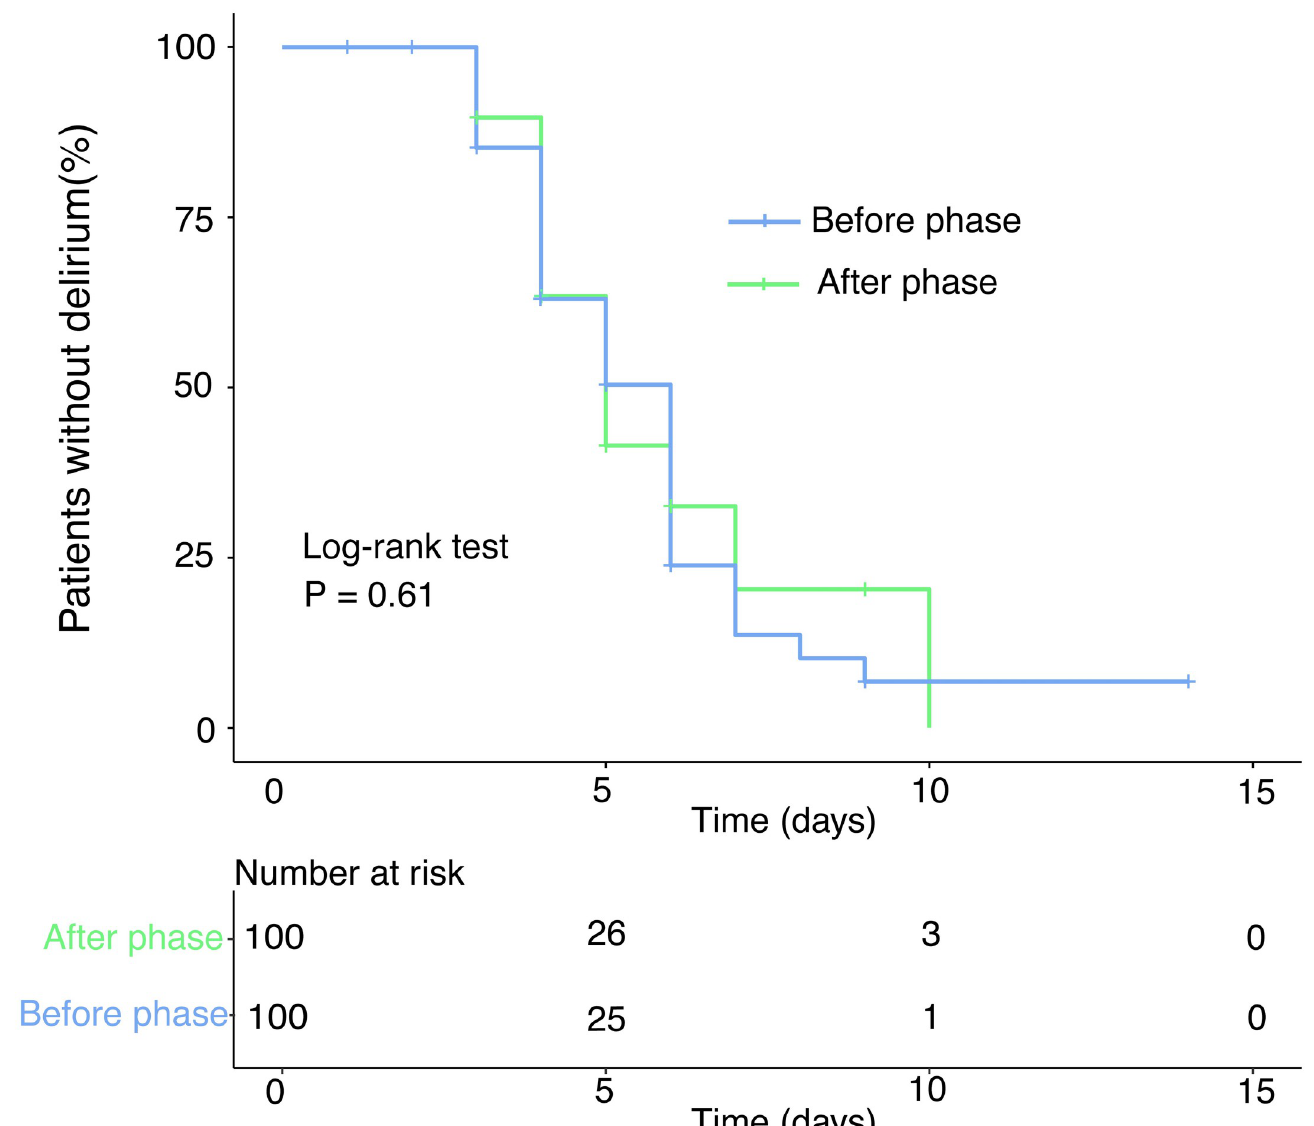
Fig 3. Kaplan-Meier curve: Time until the development of delirium during the ICU stay for the before and after phases.